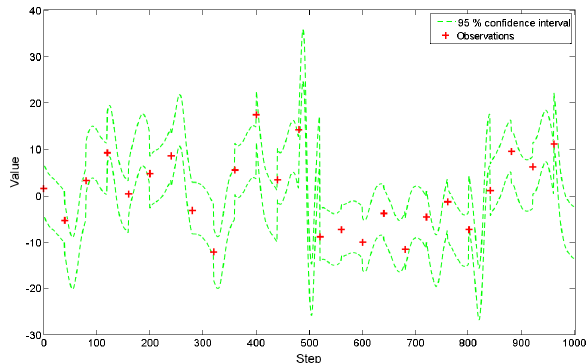
Figure 2. The 95% confidence interval computed by posterior par- ticles. The green dashed lines denote the upper and lower limits of the interval and the red crosses are observations.